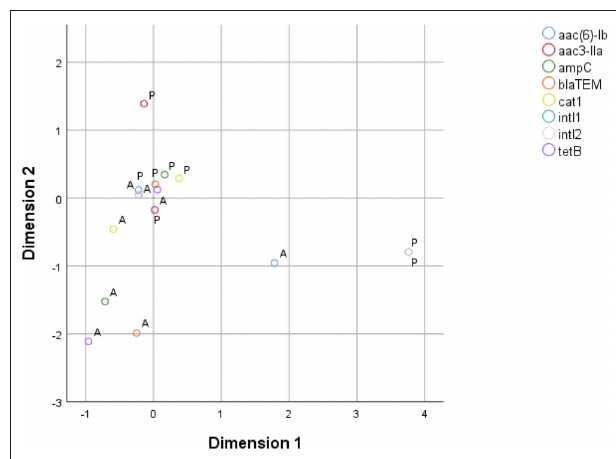
FIGURE 2 | Two-dimension correspondence map for resistance genes (A, absence; P, presence).